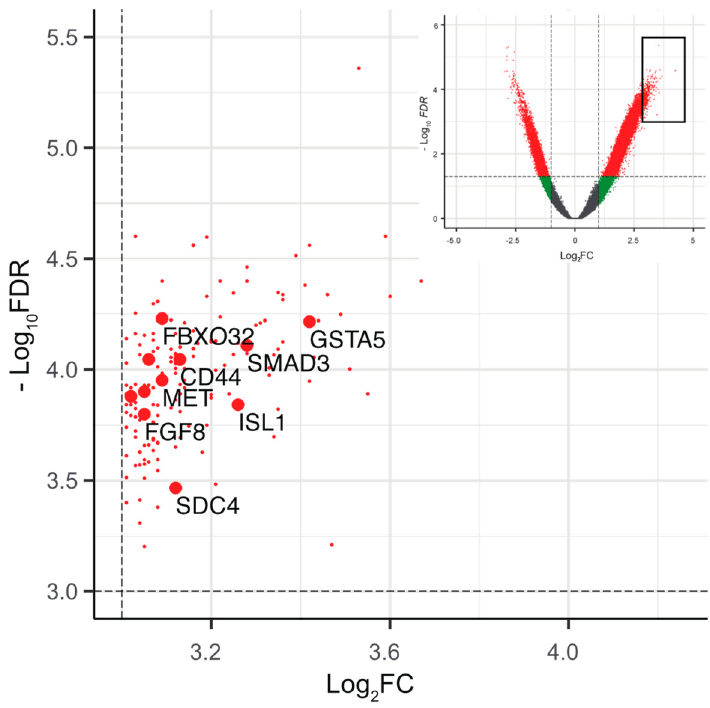
Figure 7. Epigenetic landscape of driver mutations in pan-negative LUADs. Partially enlarged volcano plots showing the top annotated DERs (log2FC > 3, − log10 FDR > 3, n = 208, red dots) in pan-negative cases. The annotated genes associated with the Kyoto Encyclopedia of Genes and Genomes (KEGG) pathway are highlighted in larger red dots (see Supplementary Table S4). The inset shows the entire plots to indicate the enlarged area (black square) .